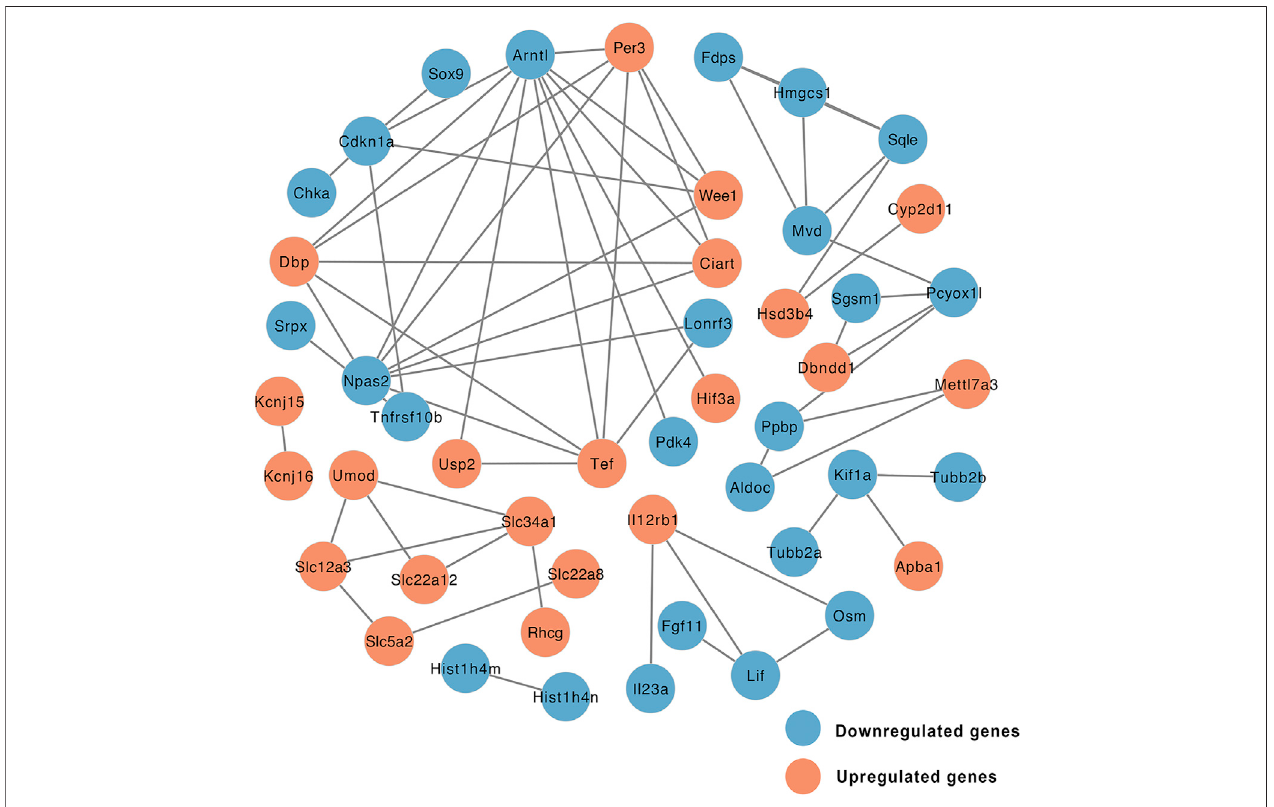
FIGURE 5 | Network of protein-protein interaction (PPI) of DEGs between EMP and HFD group (orange node: upregulated genes, blue node: downregulated genes).